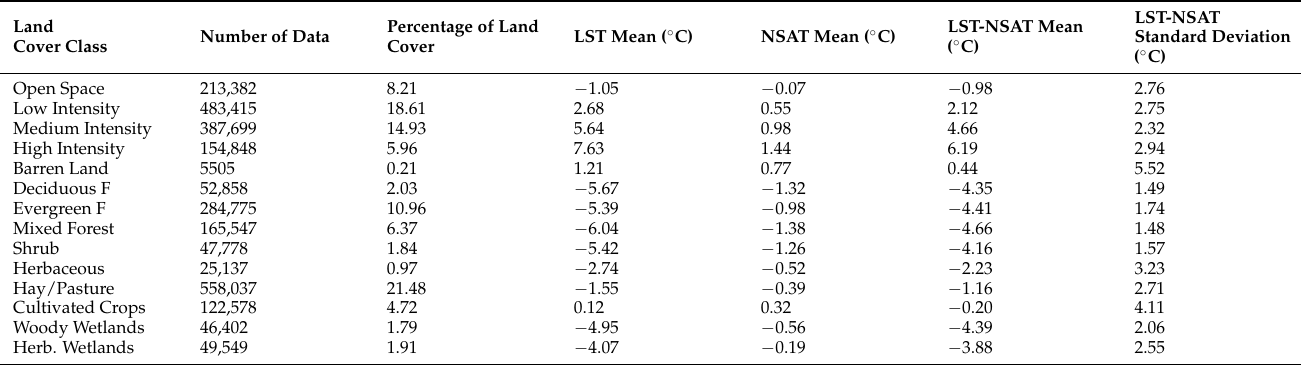
Table 3. Descriptive statistics for Portland.